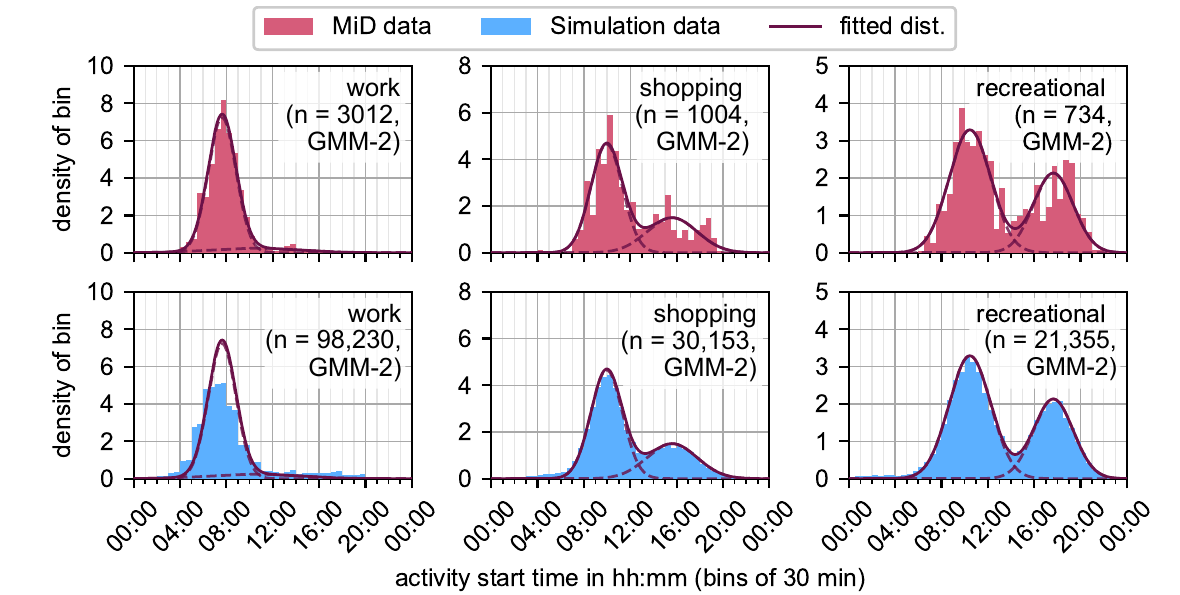
Figure 13. Start times of the first activity per activity type. Comparison of simulation and MID.